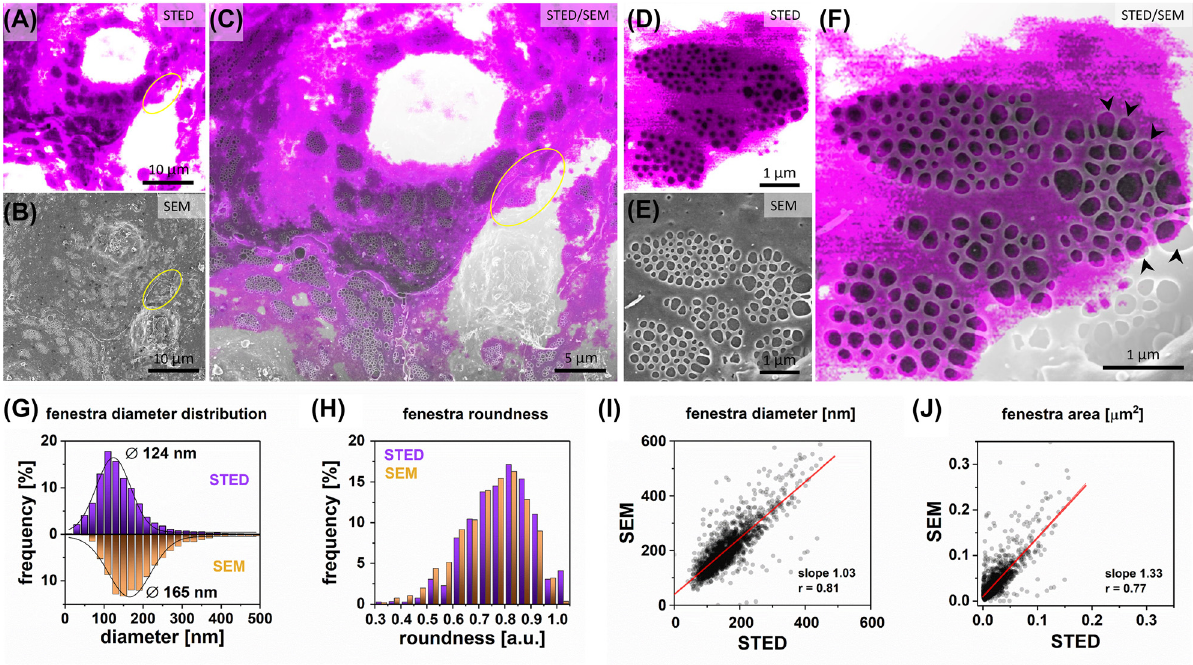
Figure 2: Correlative STED and SEM microscopy. Firstly, STED measurements were performed for wet-fixed LSEC labeled with CellMask Deep Red; (A) A representative STED image of LSEC is presented. To achievethe highestpossible contrastfor fenestrated regions, areas corresponding to the cell nucleiweresaturated(white)due to thehighsignalintensity.(B)Thesamplewasdehydrated,thecorresponding areawaslocalizedandmeasuredwithSEM.(C)BothSTEDand SEM images were then correlated. (D – F) High-magnification images allow for precise identification of all of the fenestrations within sieve plates. Fenestrations in the center of the sieve plate were less dilated than those on the edges (arrowheads). 1909 fenestrations were identified in the collected images and analyzed in a one-to-one manner. (G) Histogram of fenestration diameter distribution. The black lines represent fitted Gaussian curves from which the mean diameter was calculated at the peak of the distribution (STED 124 nm ± 44 nm, SEM 165 nm ± 64 nm). (H) Distribution of fenestration roundness measured by STED and SEM. A comparison of individual fenestration diameter I and area J indicate uniform dilation of fenestrations in